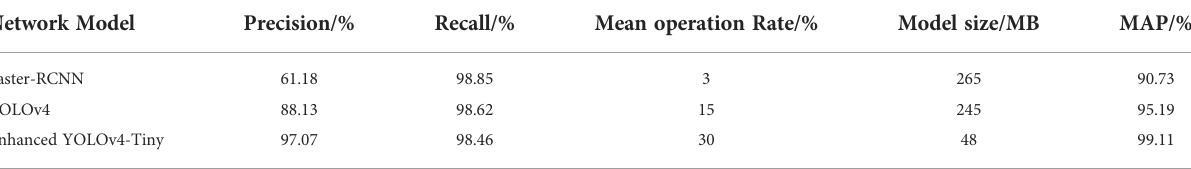
TABLE 2 Comprehensive comparison of different detection networks for sugarcane stem node detection.